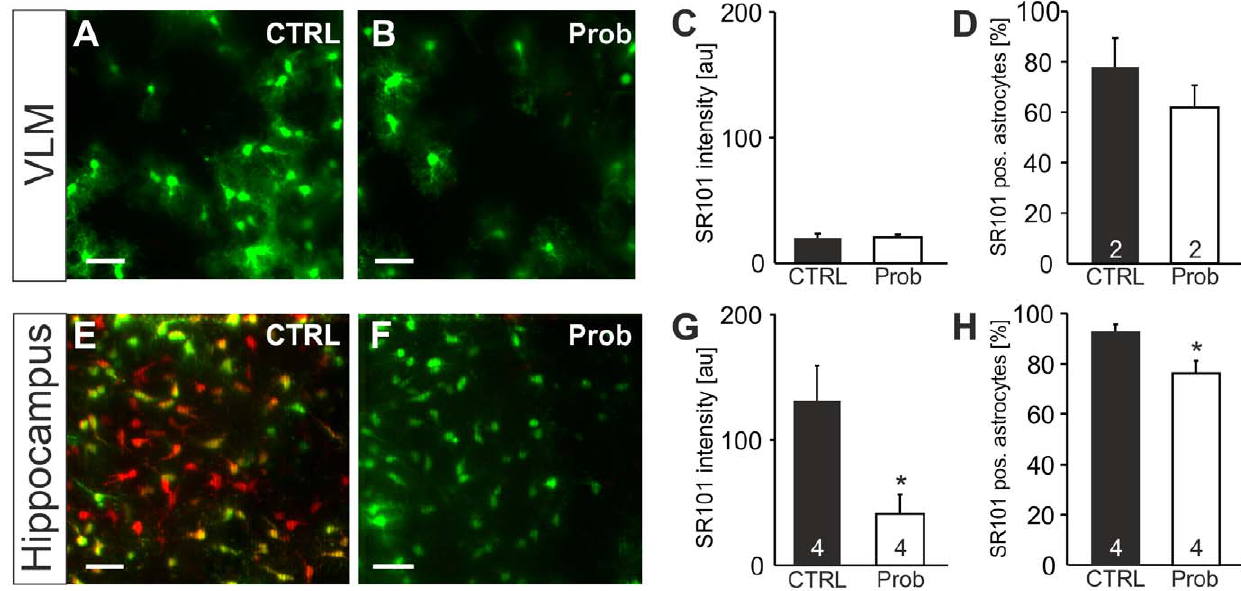
Figure 9. Effect of probenecid on SR101-labeling. A: Overlay of astroglial EGFP-fluorescence and SR101-fluorescence in the VLM after staining in CTRL conditions. B: Overlay of astroglial EGFP- and SR101-fluorescence after staining with Probenecid (Prob, 1 mM). C,D: Statistical comparison shows no change of astroglial SR101-labeling in the VLM. E: Overlay of astroglial EGFP- and SR101-fluorescence in the hippocampus after staining in CTRL conditions. F: Overlay of astroglial EGFP- and SR101-fluorescence after staining with Probenecid present in the staining solution shows a reduction of astroglial SR101-labeling in hippocampal astrocytes. G,H: Statistical comparison reveals a significant reduction of the intensity (G) as well as the percentage of EGFP-positive astrocytes that were also labeled (H). Scale bars: 40 m m.